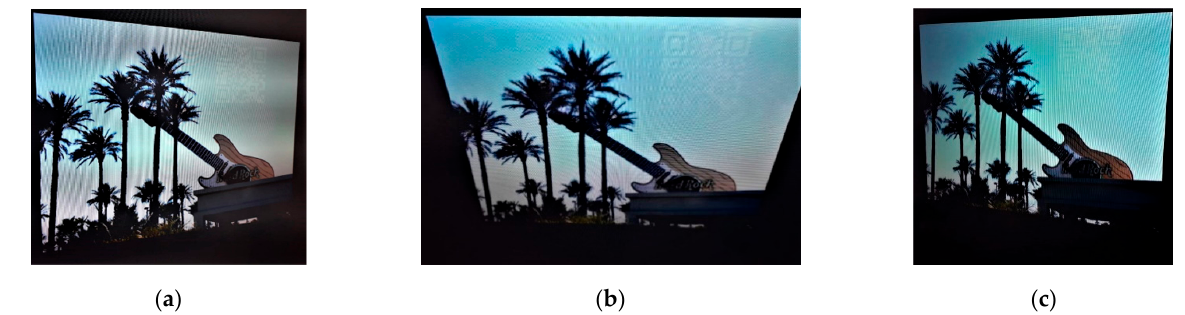
Figure 13. Sample set of images with QR code exhibited by the angle of vision. ( a ) Azimuth negative adjustment, ( b ) Elevation positive adjustment, ( c ) Azimuth positive adjustment.